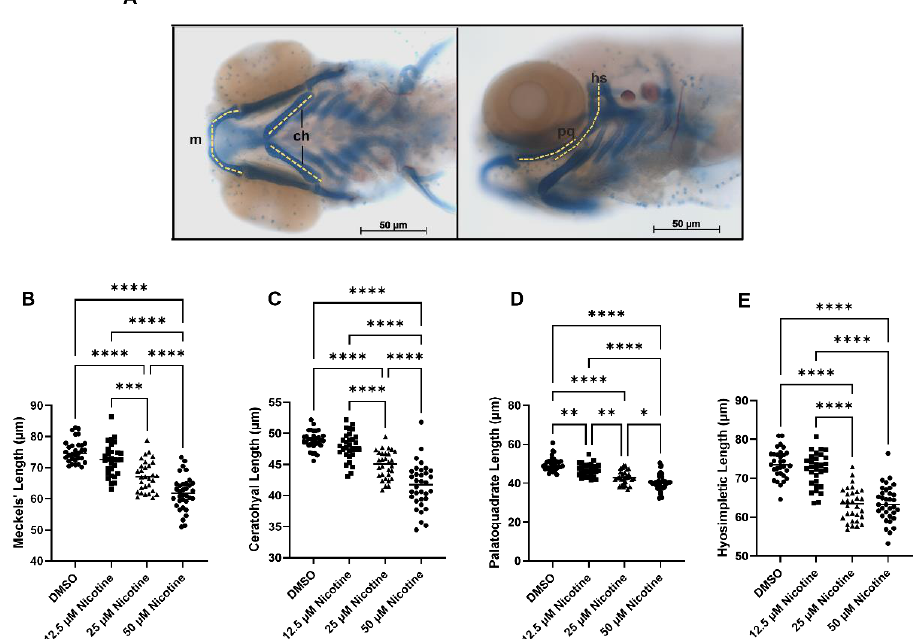
Figure 3. Embryonic nicotine exposure effects viscerocranial cartilages length. ( A ) Viscerocranial cartilages measurements. ( B ) Meckel’s length, ( C ) Ceratohyal length, ( D ) Palatoquadrate length, and ( E ) Hyosimpletic length. The size of all viscerocranial cartilages decreased with embryonic exposure to nicotine in a dose-dependent manner. Sample sizes are: DMSO n = 31; 12.5 µ M nicotine n = 30; 25 µ M nicotine n = 30; and 50 µ M nicotine n = 34; m, meckel’s cartilage; ch, ceratohyal; pq, palatoquadrate; hs, hyosimpletic. * = p < 0.05; ** = p < 0.01; *** = p < 0.001; **** = p < 0.0001. All images were captured at 10 × magnification. Scale bar 50 µ